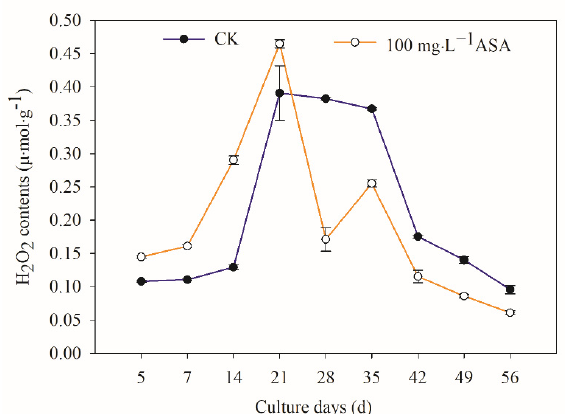
Figure 5. Effects of 0 and 100 mg·L − 1 ASA treatments on intracellular H 2 O 2 content during somatic embryogenesis of Fraxinus mandshurica provenance 3. The x -axis represents the culturing days, and the y -axis represents the intracellular H 2 O 2 content. Error bars show the standard error of the mean.